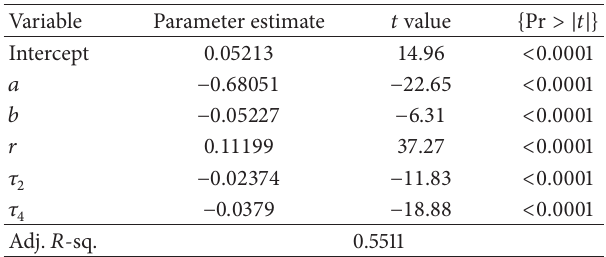
Table 3: Statistics of multiple linear regression for sampling level.